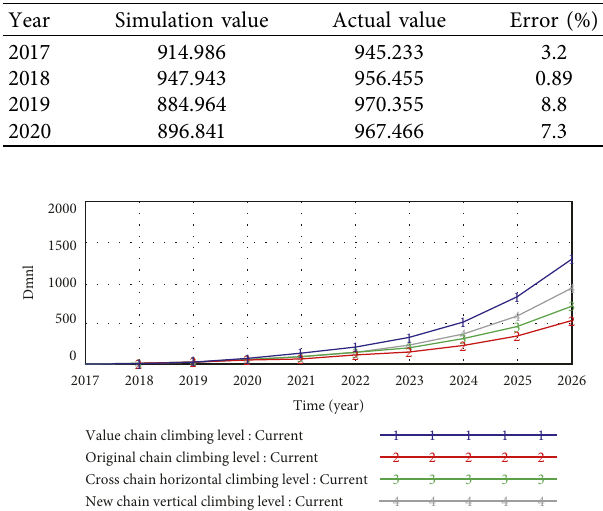
Figure 4: Value chain climbing trend